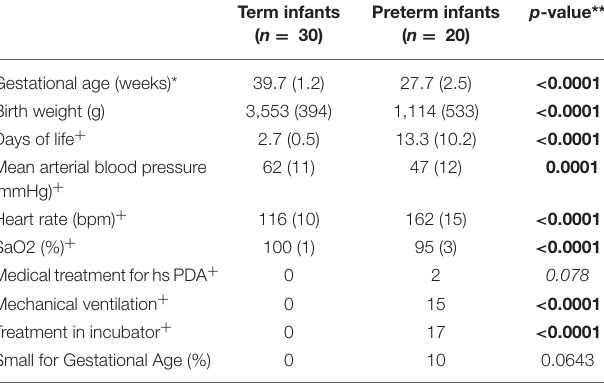
TABLE 1 | Clinical data presented as mean and (SD).